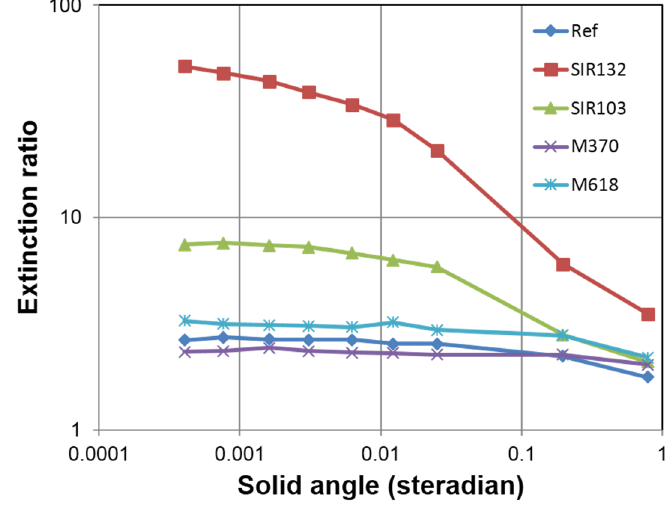
Figure 6. Extinction ratio dependence on the solid angle. Wavelength: 1.523 μ